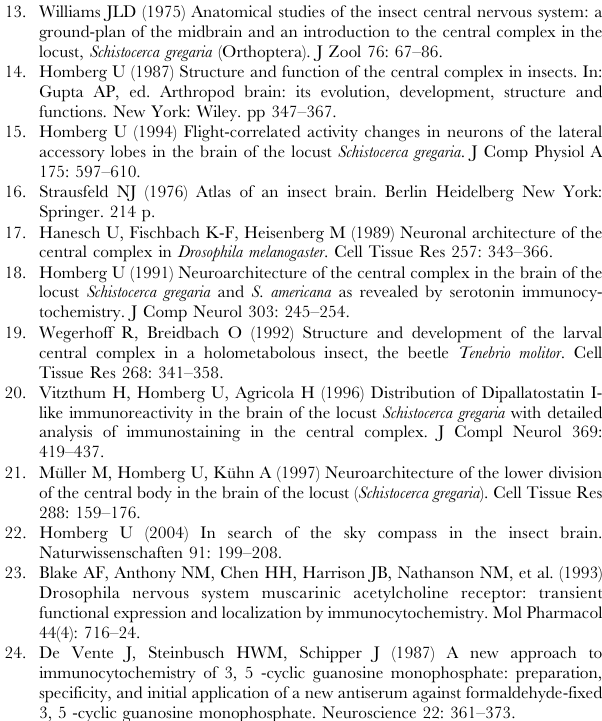
Figure S2 Muscarinic AChR immunoreactivity in the brain of Ch. biguttulus outside the central complex. Intensely labeled neurites were detected in the medulla of the optic lobes (A and B) and emerging from in the inner core of the antennal lobe (C). The antibody used in our study labeled the same brain regions in D. melanogaster . Immunoreactivity was also detected in the calyx (D) and the pedunculus (E) of the mushroom bodies of Ch. biguttulus . Though this has so far not been described for D. melanogaster , physiological studies on honeybees implicated a functional role for muscarinergic signaling in this brain